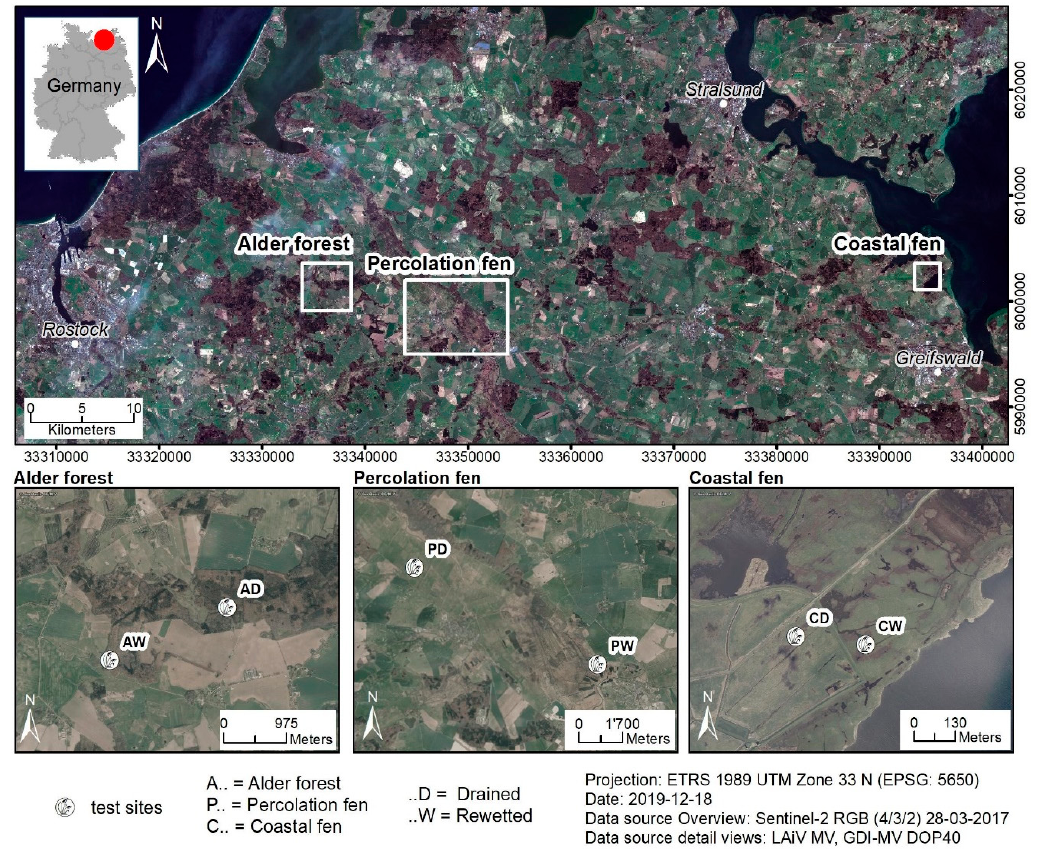
Figure 2. Locations of the WETSCAPES study area (inset on the top left), the study site pairs in Mecklenburg-Vorpommern (top) and locations of the paired sites (one drained [D], one rewetted [W]) for the three major peatland types covered (bottom), from left to right: Alder forest (A), Percolation fen (P), Coastal fen (C).